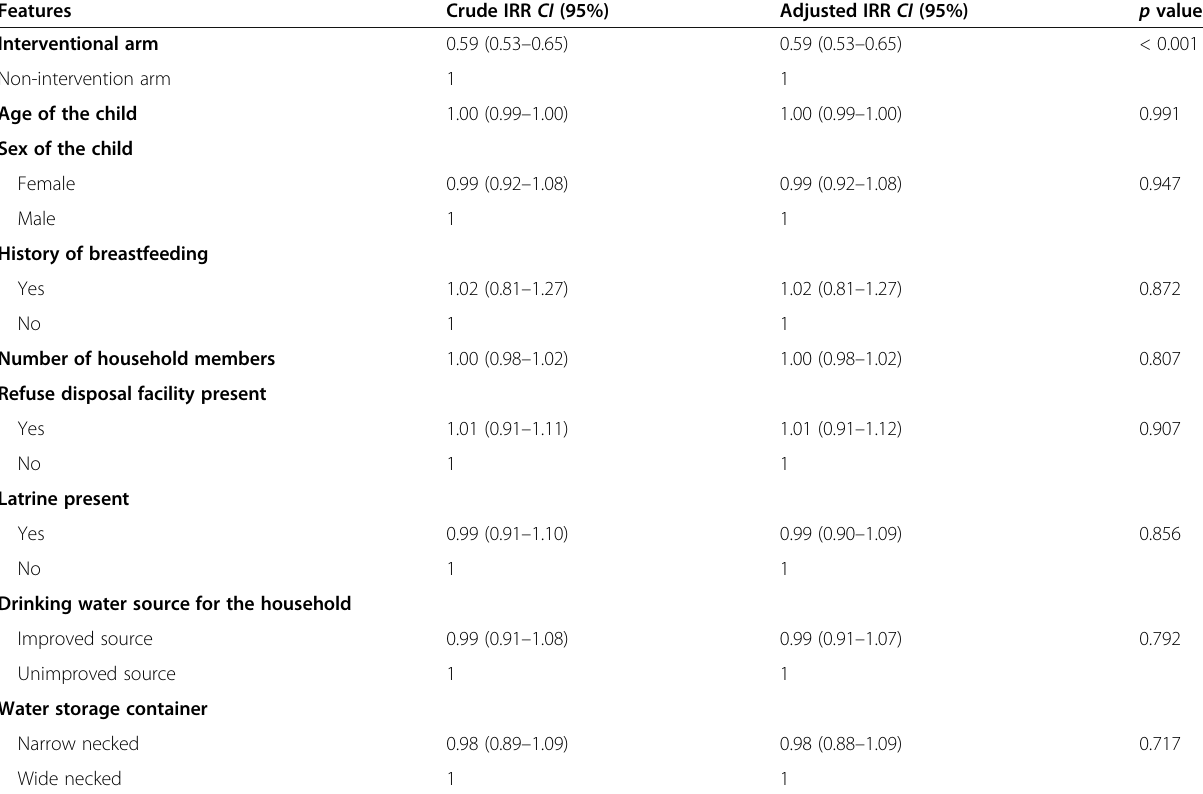
Table 2 Effect of handwashing on diarrheal incidence in children under 5 years old as analyzed by multivariable analysis in rural kebeles of Dire Dawa, east Ethiopia,